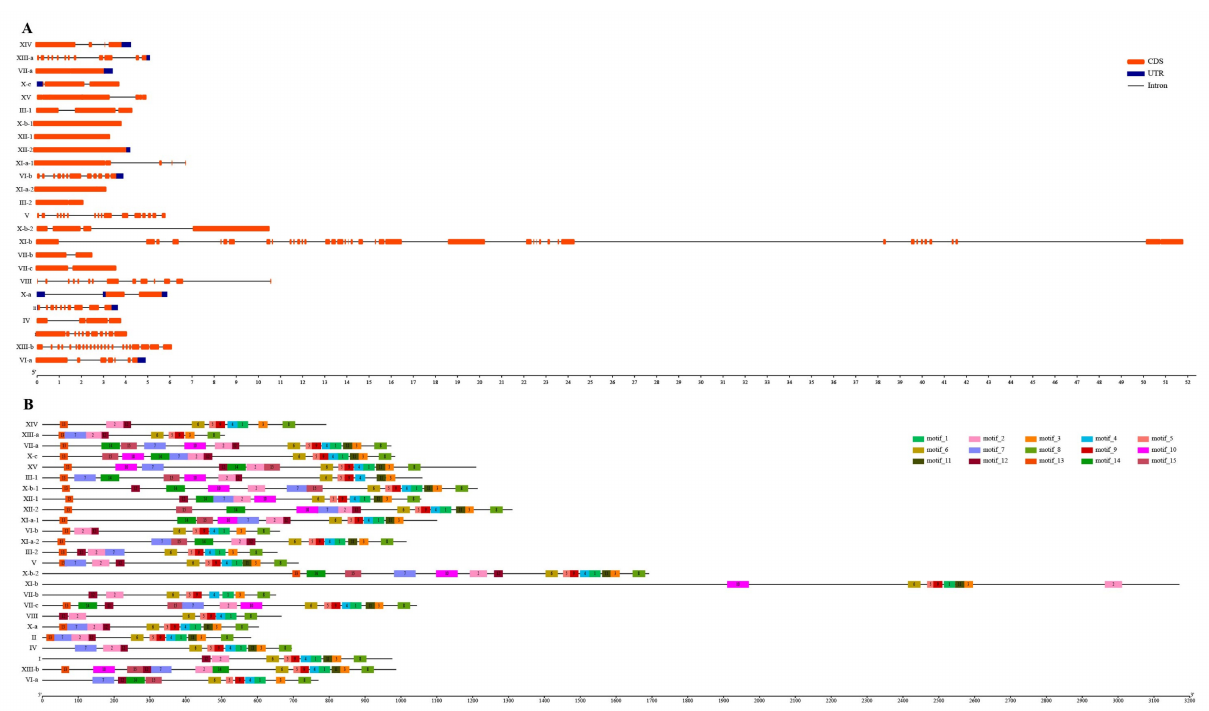
Figure 3. Representative exon–intron ( A ) and conserved motifs structure ( B ) of each S. spontaneum LRR-RLK subfamily. ( A ) Exon–intron structures of SsLRR-RLKs . Untranslated regions (UTRs), exons and introns are represented by blue boxes, red boxes and black lines, respectively. ( B ) The motif distribution of SsLRR-RLK proteins. The 15 predicted motifs are represented by distinct color boxes using the MEME